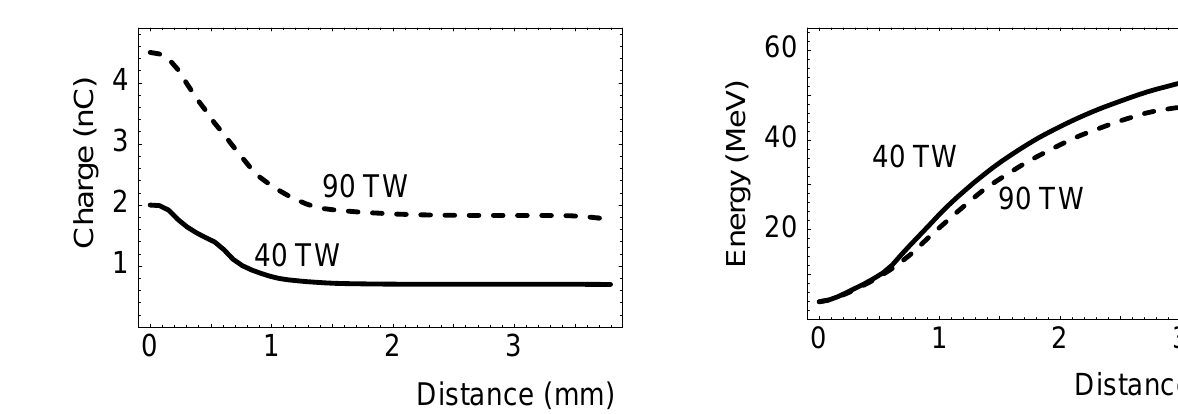
FIG. 15. Average energy as a function of propagation distance for the 40 TW case and the 90 TW case.